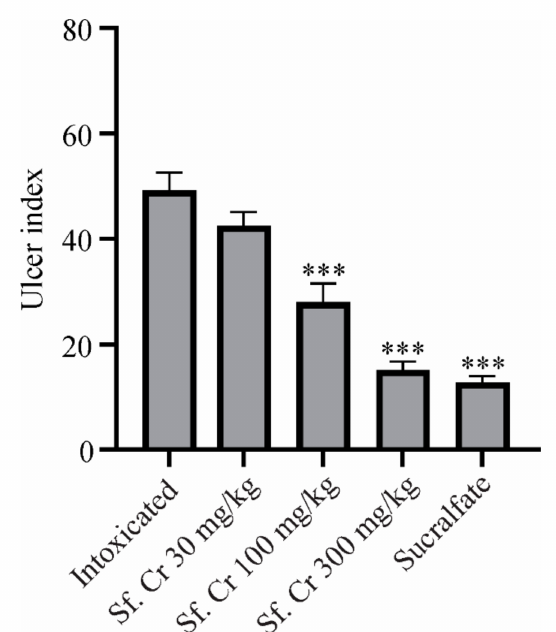
Figure 3. Effect of Sf.Cr on ulcer index. Rats were pre-treated orally with normal saline, sucralfate, and Sf.Cr. Data are presented as Mean ± SEM (n = 6). Significance was determined by One way ANOVA followed by Dunnett’s test and described as (***) if p < 0.001 compared with the intoxicated